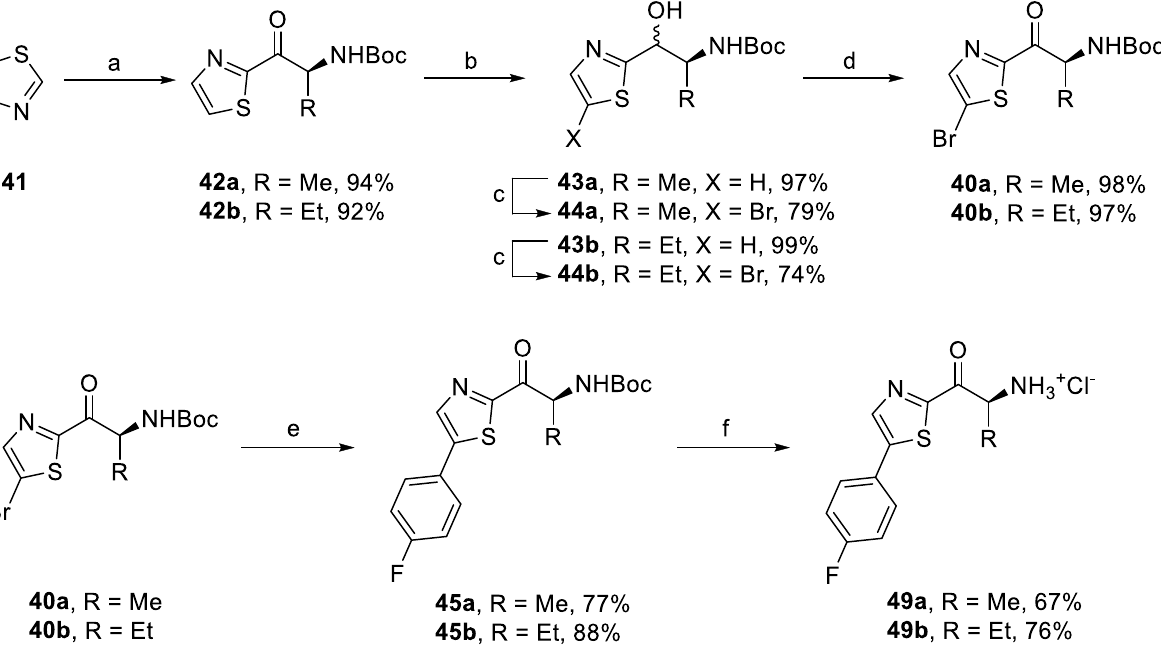
Figure 12. Synthesis of triazole derivatives based on SAR. Reagents and conditions: (a) KSCN, Br 2 , AcOH, r.t., 79%; (b) i- AmONO, THF, reflux; 72%, (c) 14 or 23e , i- PrMgCl.LiCl, -10 °C to r.t., 79 – 83%;